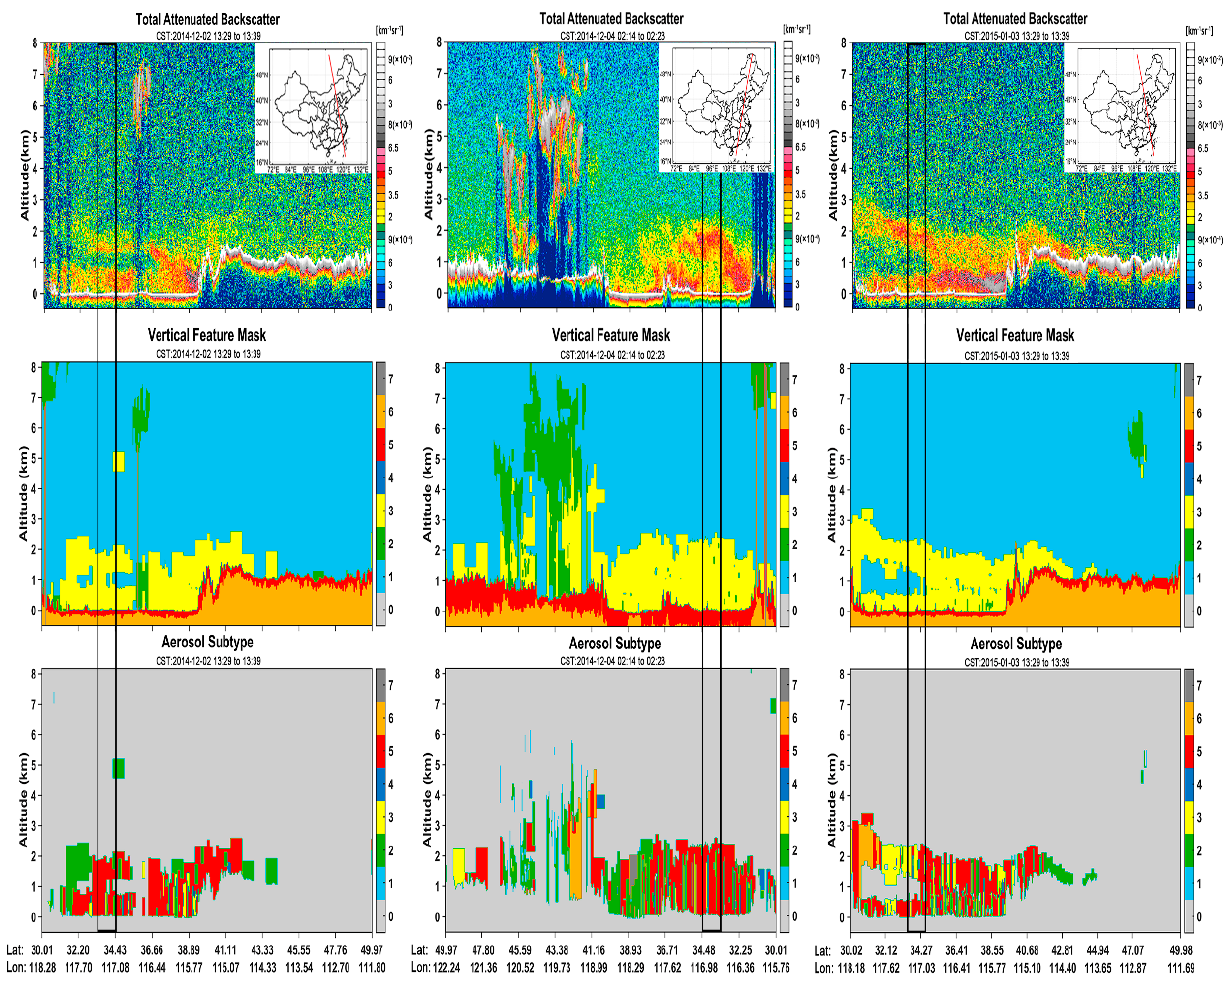
Figure 8. CALIPSO 523 nm total attenuation backscattering coefficient, vertical feature masks, and aerosol subtypes on 2 December 2014 ( left ), 4 December 2014 ( middle ), and 3 January 2015 ( right ) orbits and their ground tracks (China Standard Time (CST)). The black box represents the scope of Xuzhou.